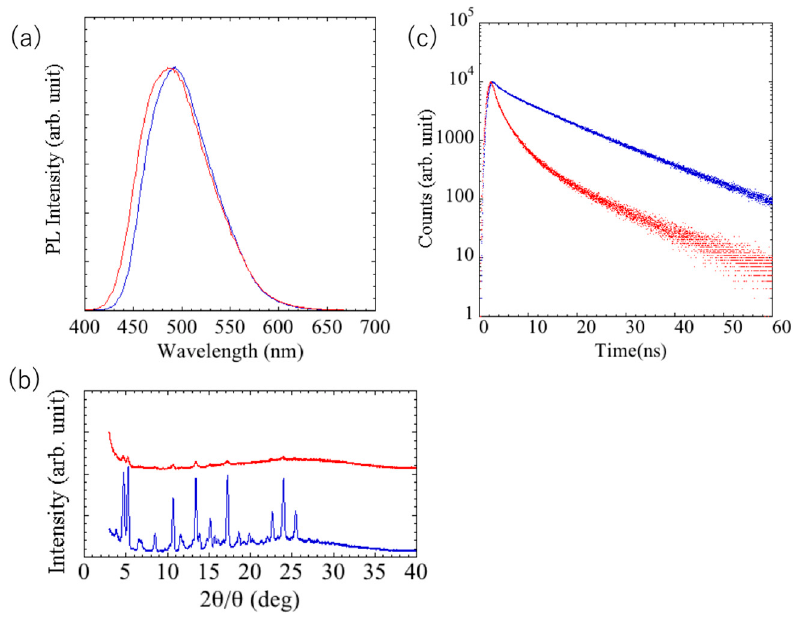
Figure 6. ( a ) PL spectrum, ( b ) XRD, and ( c ) fluorescent decay profile of recrystallized 2ECh before (blue) and after (red) mechanical grinding.